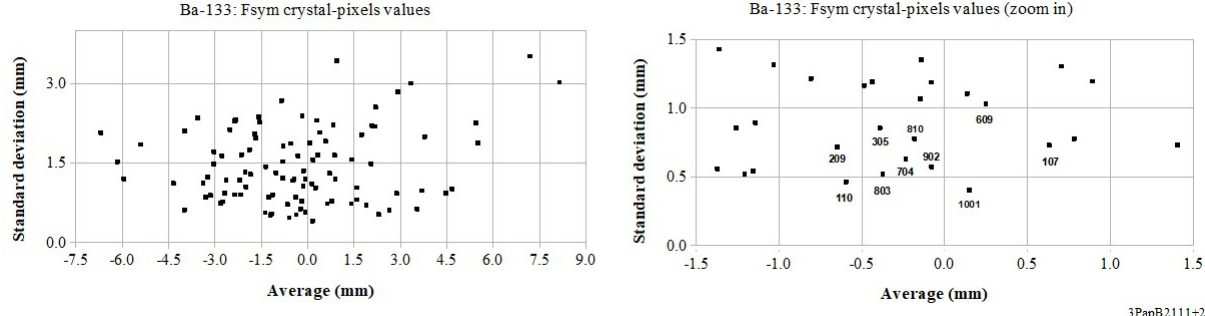
Figure A15. Plot of standard deviation Vs. average of Fsym values ( left ) obtained for all the crystal-pixels of the 10 × 10 array under Ba-133 irradiation. A relevant overall dispersion of results is shown, suggesting to search for a subset of pixels showing the most similar symmetry properties. Zoom-in ( right ) of the central-zone of the plot on the left, showing the decuple of pixels with the smaller charge-spread values around the origin. The selected decuple was, in RRCC ascending order, 107, 110, 209, 305, 609, 704, 803, 810, 902, and 1001 with distance-values from origin ranging from 0.40- to 1.03-mm.